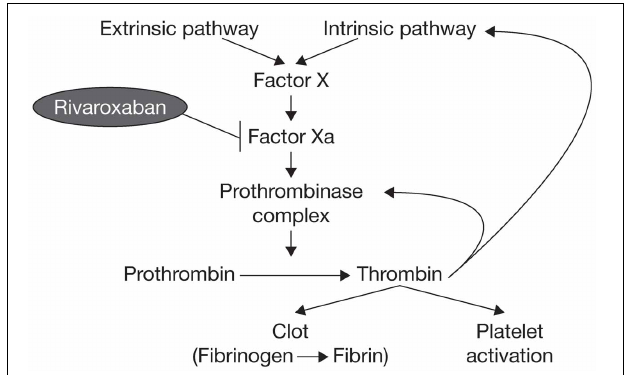
FIGURE 1 | The blood coagulation